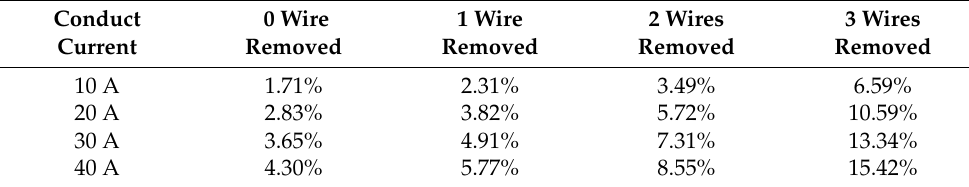
Figure 9. FEM results. ( a ) Power loss of IGBT module; ( b ) case temperature at case point. Not only the power loss but also the proportion of bond wires to total power loss increase after bond wire lift-off, as shown in Table 3. The proportion of bond wires in total power loss rises after lift-off, increasing from 1.7% to 6.59% at 10 A, 2.83% to 10.59% at 20 A, 3.65% to 13.34% at 30 A, and 4.3% to 15.42% at 40 A. The proportion of bond wire power current due to the lower on-state resistance of IGBT die. Table 3. Proportion of bond wire power loss in total